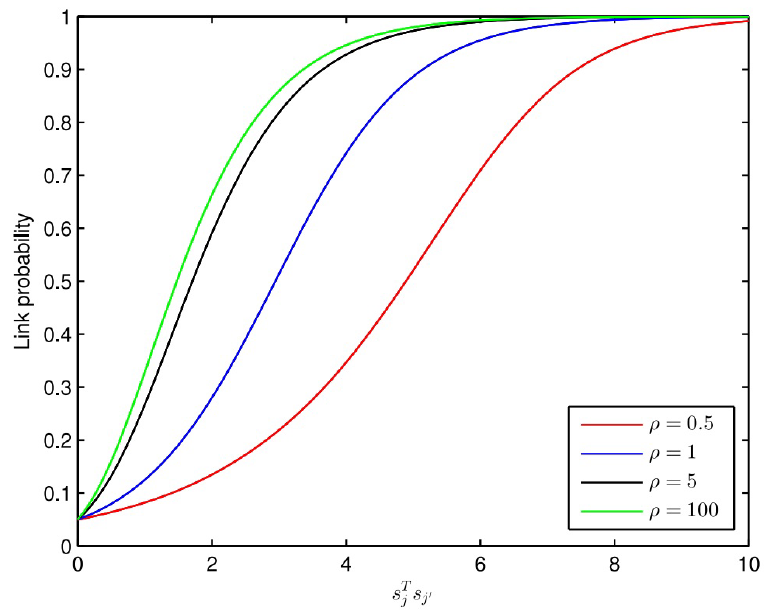
Figure 3. Plotting of link probability functions by varying